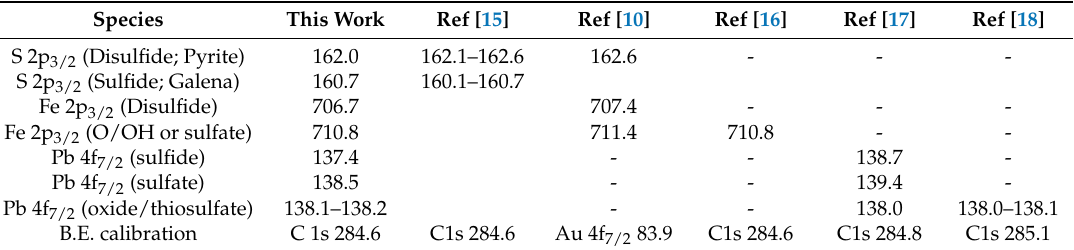
Table 1. Position of XPS signals for species relevant for this work, as obtained from the literature. All values are given in